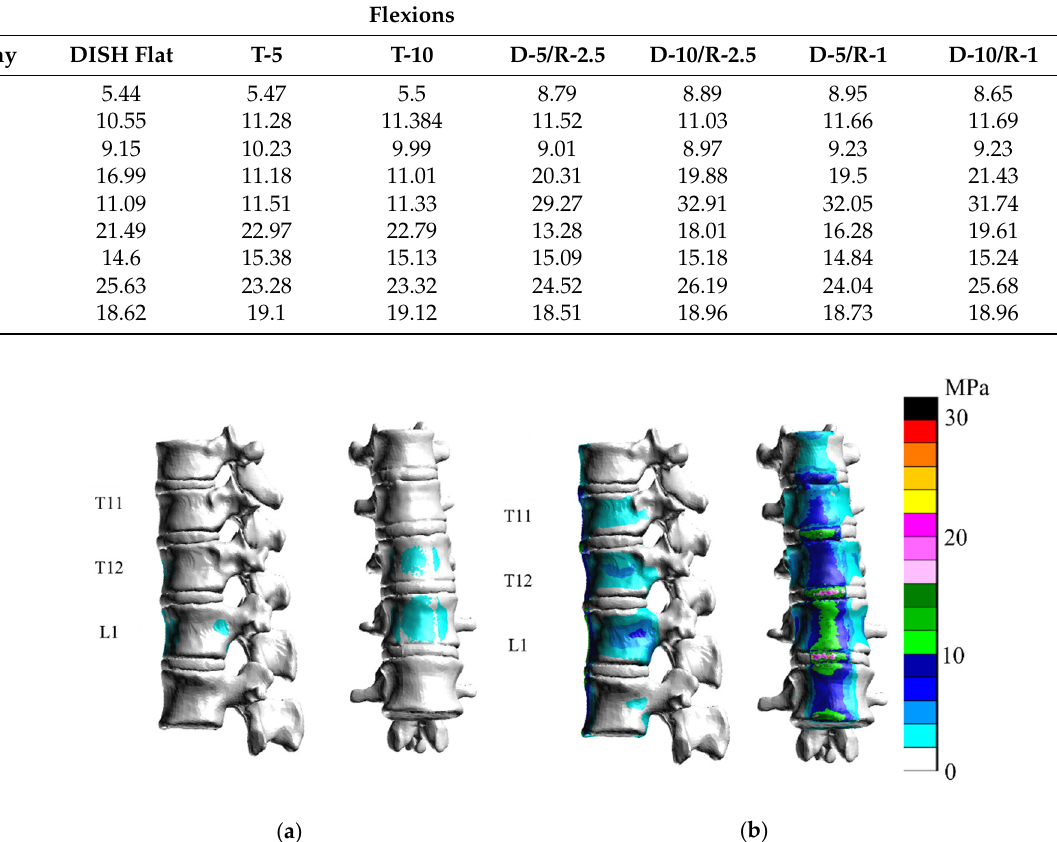
Figure 11. Only vertebral bodies and discs are shown for clarity. The right bar is color-coded according to stress (MPa). Stress diagrams of ( a ) the healthy model and ( b ) the DISH flat model. Stresses were greater in the flat model in flexion than in the healthy model.